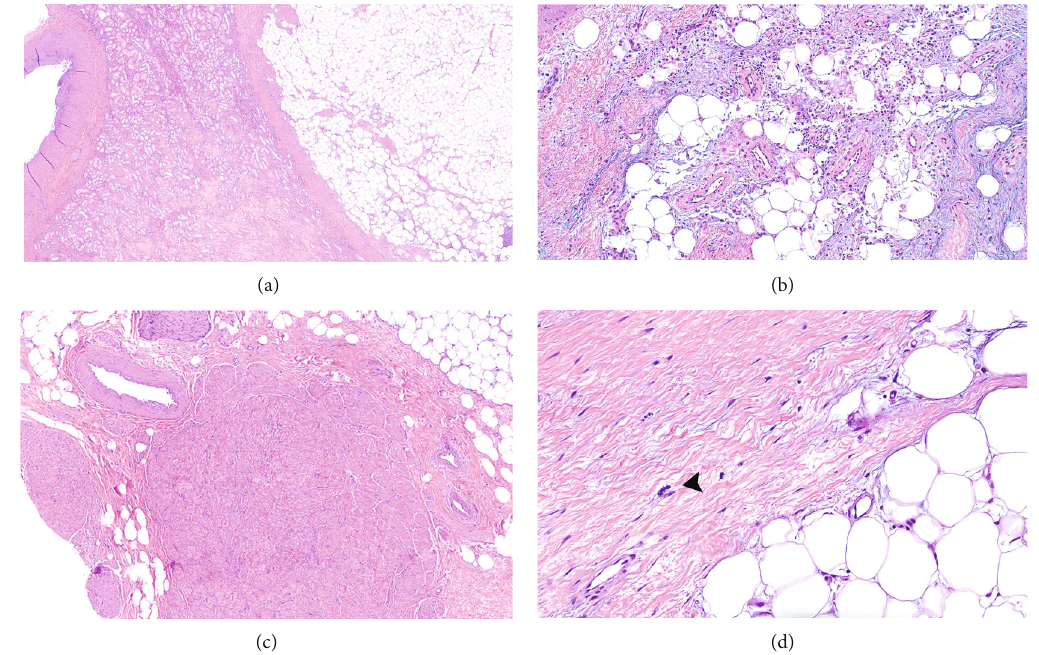
Figure 3: Microphotograph of the right kidney. (a) Well-demarcated mature adipose tissue and adjacent renal parenchyma. (b) Renal sinus fat showing in fl ammatory changes with areas of hyalinization and fat necrosis. (c) The lipomatous proliferation of the renal sinus fat contains fi brous septae and occasional thick-walled vessels with prominent smooth muscle bundles. (d) Rare atypical stromal cell (arrowhead), otherwise no signi fi cant cytologic atypia or lipoblasts were identi fi